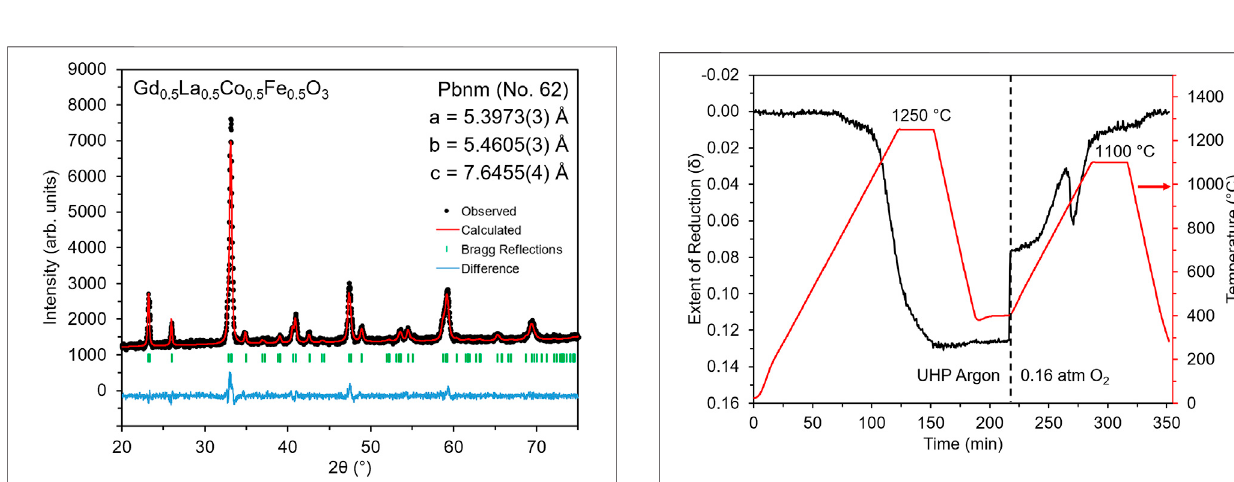
2 CoFeO 6 (L2CF), GdLaCoFeO 6 (GLCF), and